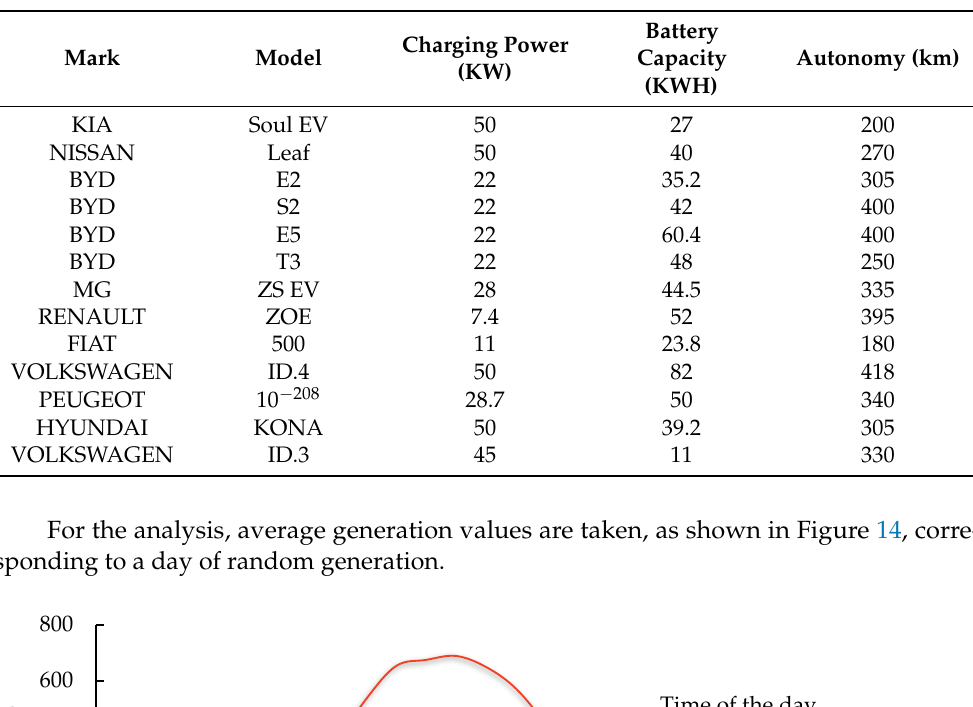
Table 7. Characteristic powers of the main EVs in the study.